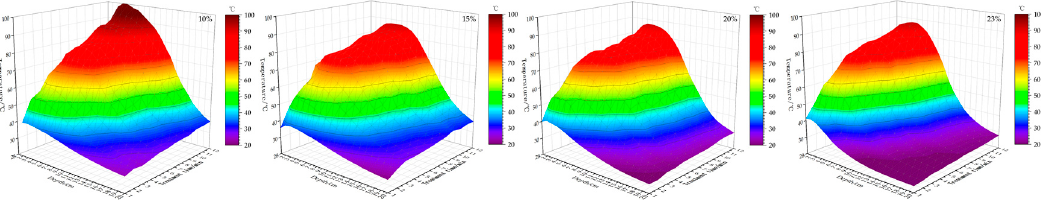
Figure 27. Variation in the internal temperature of black soil with irradiation time and soil depth.